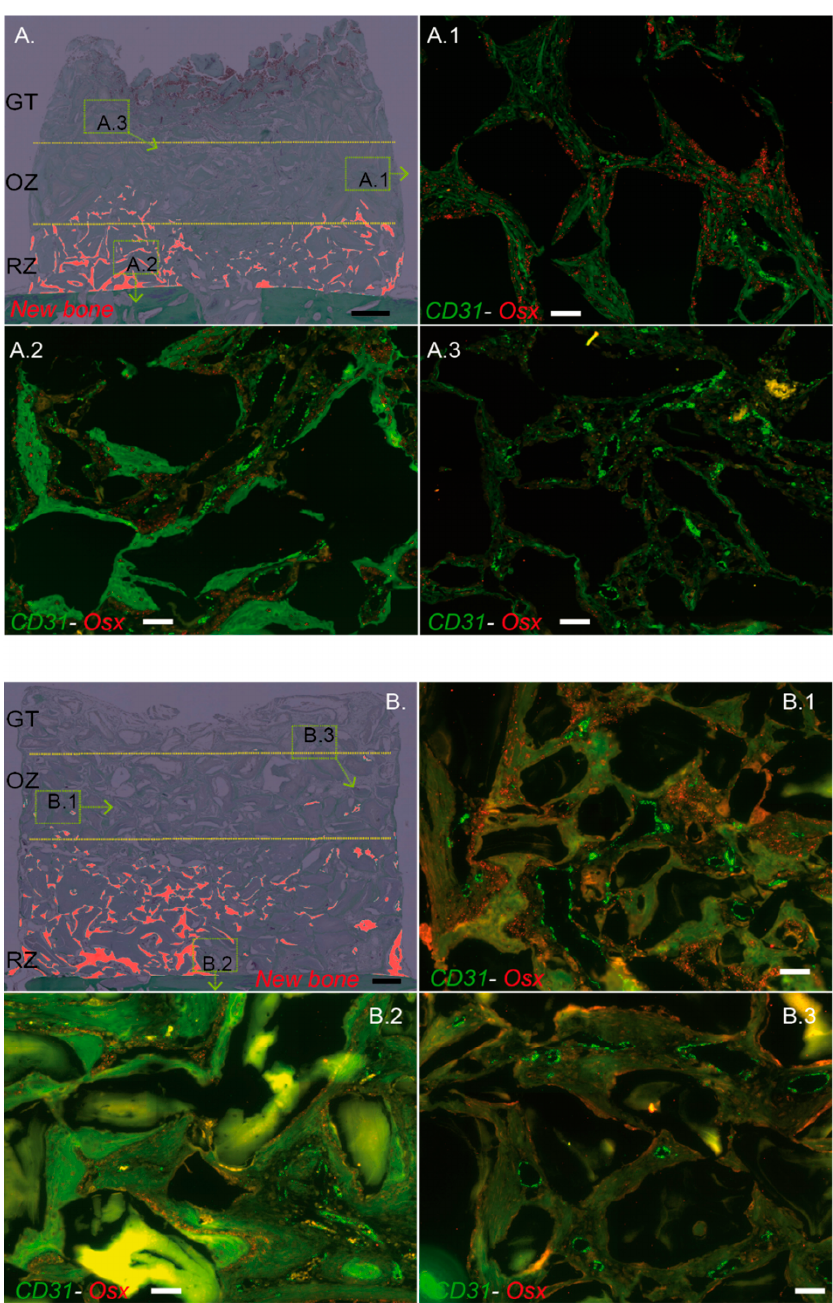
Figure 3. Description of the dynamic and controlled model of osteogenesis. Cylinder contents pictures from Figure 2A,B were digitally processed to highlight the new bone in red (( A ), 2 weeks; ( B ), 4 weeks). RZ, OZ and GT are delimited by yellow dotted lines. A representative zone from OZ ( A.1 , B.1 ), RZ ( A.2 , B.2 ), and GT ( A.3 , B.3 ) was magnified and analyzed by RNA hybridization for CD31 (green dots) and Osterix (OSX, red dots). Note that each zone was highly vascularized either at 2 or 4 weeks, as assessed by the green dots tagging specifically CD31 mRNA ( A.1 – 3 , B.1 – 3 ). Osteogenic precursors in which OSX is highly expressed (red dots, OSX mRNA) were mostly observed in the osteogenic zone at 2 ( A.1 ) and 4 weeks ( B.1 ). OSX precursors were also present in the remodeling zone but at a lower rate when compared to OZ, either at 2 or 4 weeks ( A.2 , B.2 ), respectively, whereas they were very sparsely observed within the GT ( A.3 , B.3 ). Black bars: 500 µ m, White bars: 100 µ